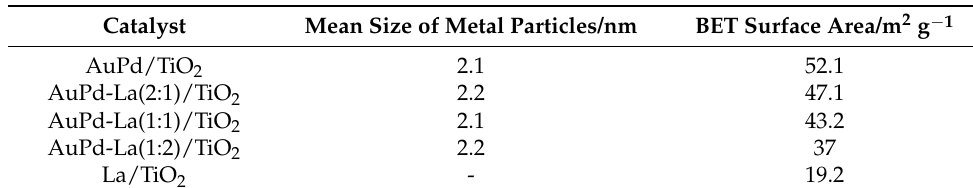
Table 1. BET surface area and AuPd particle size of AuPd, AuPd-La, and La supported on TiO 2 . Catalyst designations are given in the Experimental Section.